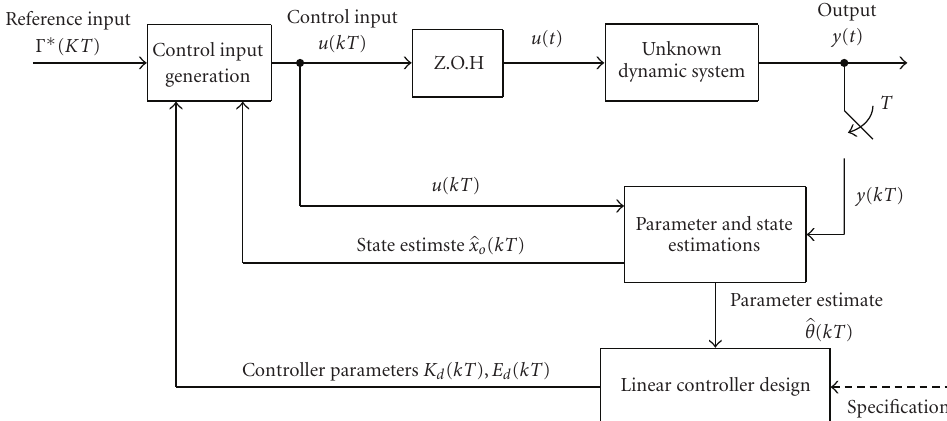
Figure 2: Block diagram of a typical state-space self-tuning